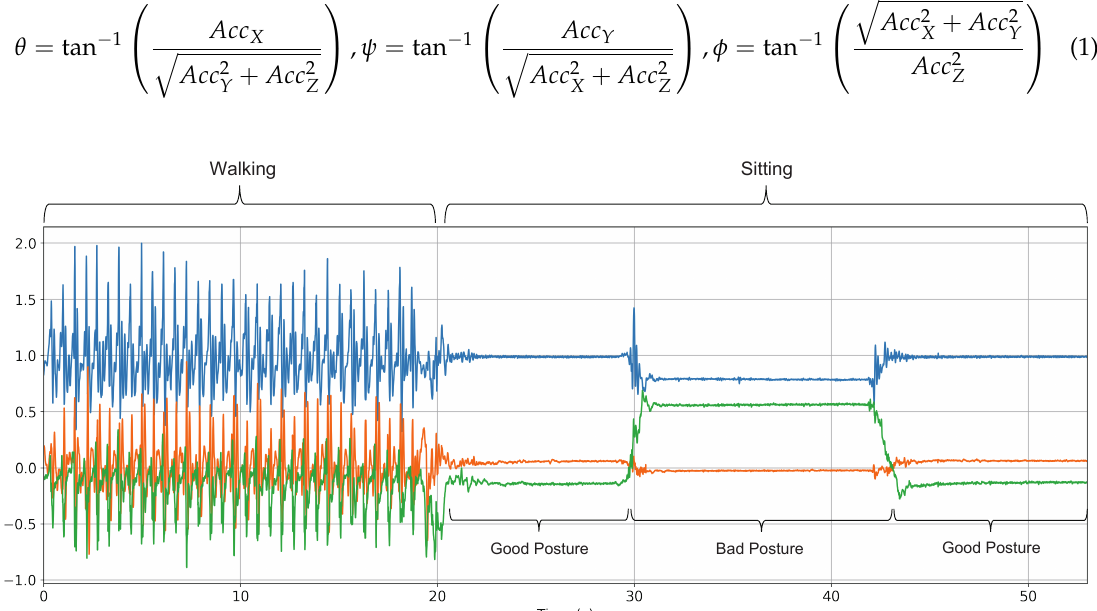
Figure 5. Raw acceleration data waveform obtained from the WaistonBelt X during walking and sitting.